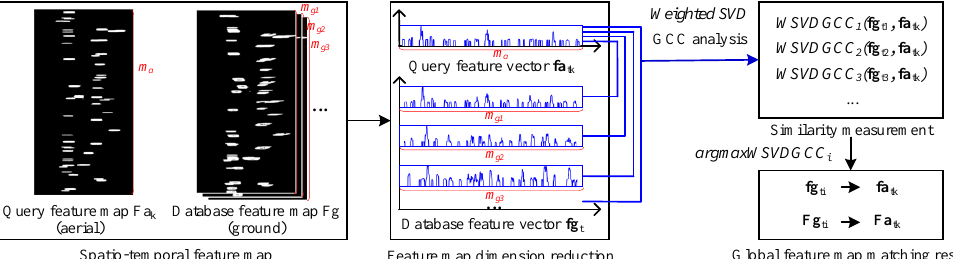
Figure 5. Global feature map matching. Query feature map Fa k from aerial assisted UAV and database feature map Fg from ground cameras are firstly transformed into one-dimensional time feature vector. Then, we measure the similarity between them according to their weighted SVD generalized cross correlation value (WSVD FS-GCC). The feature map Fg i corresponding to the highest scoring feature vector fg ti is the global matching